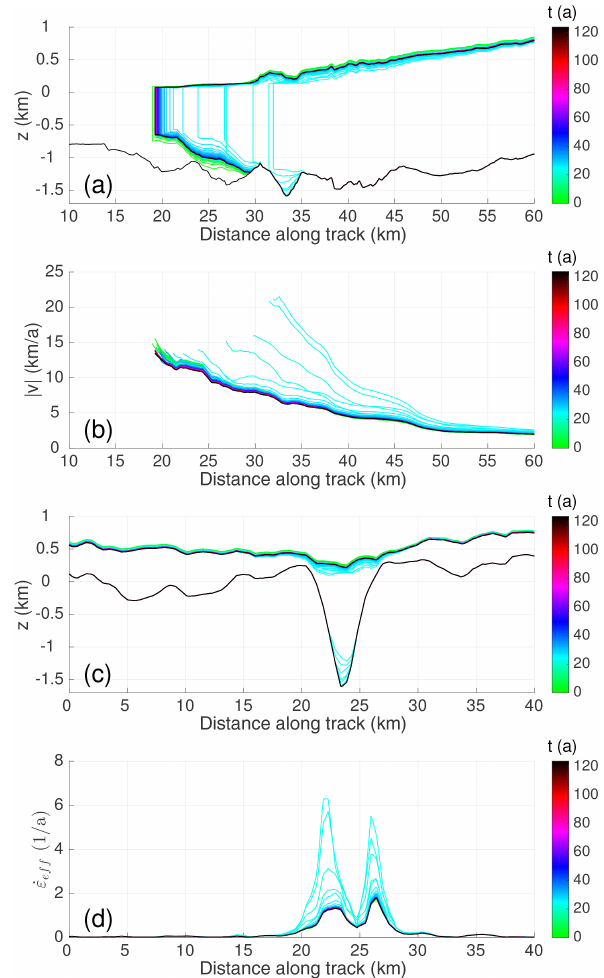
Figure 6. Section profiles of ice geometry (a) and ice velocity (b) along-trough, as well as ice geometry (c) and effective strain rates (d) across-trough for experiment C4 at the end of the calving season in October each year. Positions of the lines are given in Fig.